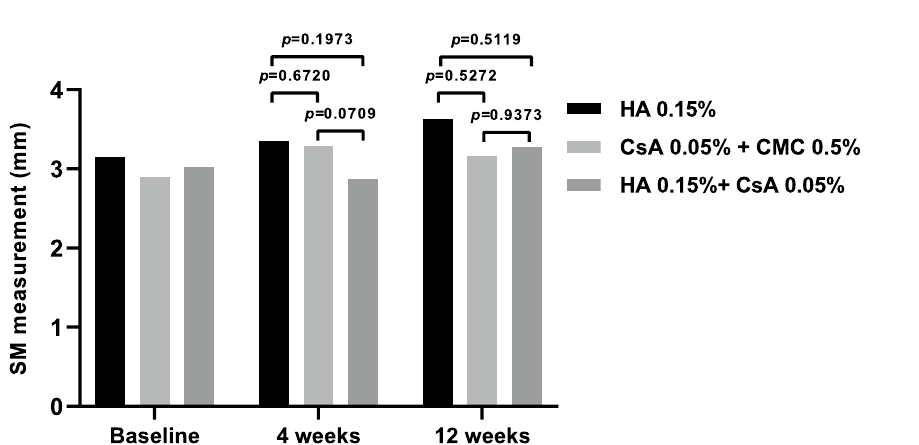
Figure 5. Strip meniscometry (SM) scores at 4 and 12 weeks in each per-protocol set group. SM scores on each follow-up period showed no significant intergroup difference (Mean value ± standard deviation, P > 0.05 by analysis of